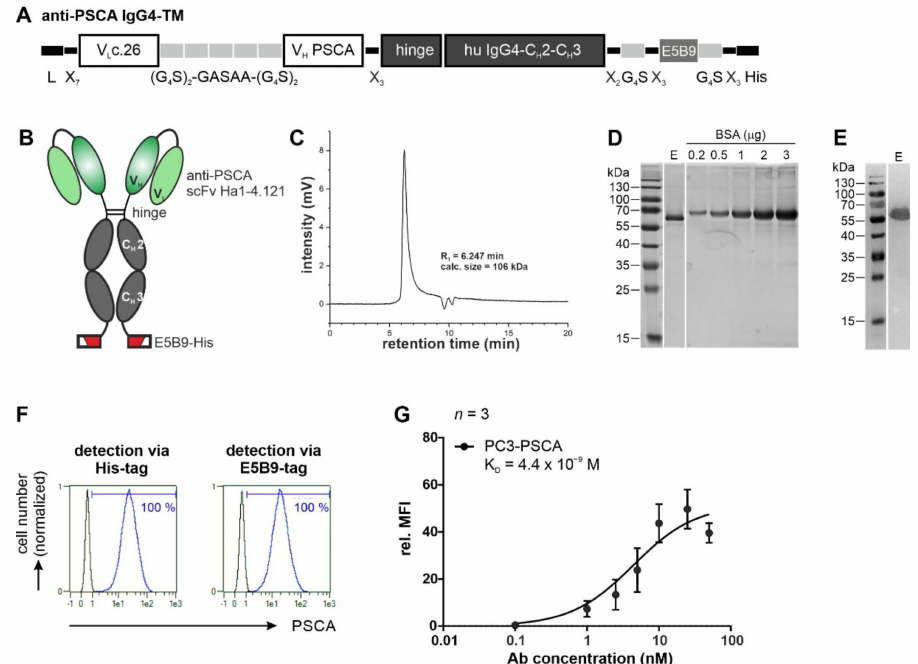
Figure 2. Biochemical characterization and binding properties of the recombinant anti-PSCA IgG4-TM. ( A ) The anti-PSCA scFv Ha1-4.1.2c.26 was fused to the hinge and Fc-region of human IgG4 molecules via flexible peptide linkers. In addition, the E5B9- and His-tag were fused to the C-terminus of the recombinant Ab. ( B ) The anti-PSCA IgG4-TM forms homodimers that are cova- lently connected via disulfide bounds in the hinge region. L, leader peptide; V L , variable domain of the light chain; V H , variable domain of the heavy chain; C H , constant domain of the heavy chain; scFv, single-chain fragment variable. ( C – E ) After purification via protein A affinity chromatog- raphy, the elution fraction ( E ) containing the anti-PSCA IgG4-TM was analyzed via ( C ) SE-HPLC and ( D , E ) SDS-PAGE. ( D ) Proteins (TM monomer, Mw = 56 kDa) separated via SDS-PAGE were stained via Quick Coomassie ® Stain solution to determine TM purity and concentration by means of a BSA standard. ( E ) After Western blotting, the anti-PSCA IgG4-TM was detected via its C-terminal His-tag. Uncropped WB in Figure S1. ( F , G ) Binding activity of the anti-PSCA IgG4-TM was evaluated by flow cytometry. PC3-PSCA cells were incubated with ( F ) 20 ng/ µ L or ( G ) increasing TM con- centrations. Binding was detected via anti-His-PE Ab or primary anti-La(5B9) mAb, and secondary PE goat anti-mouse IgG (minimal x-reactivity) Ab. ( F ) Histograms show percentage of stained cells (blue graphs) in comparison to the respective negative controls (black graphs). ( G ) For calculation of affinity towards PSCA, Ab concentrations were plotted against the relative mean fluorescence intensity (rel. MFI) values. Results of three independent experiments are shown (rel. MFI ± SEM). In a next step, binding properties were analyzed by flow cytometry using